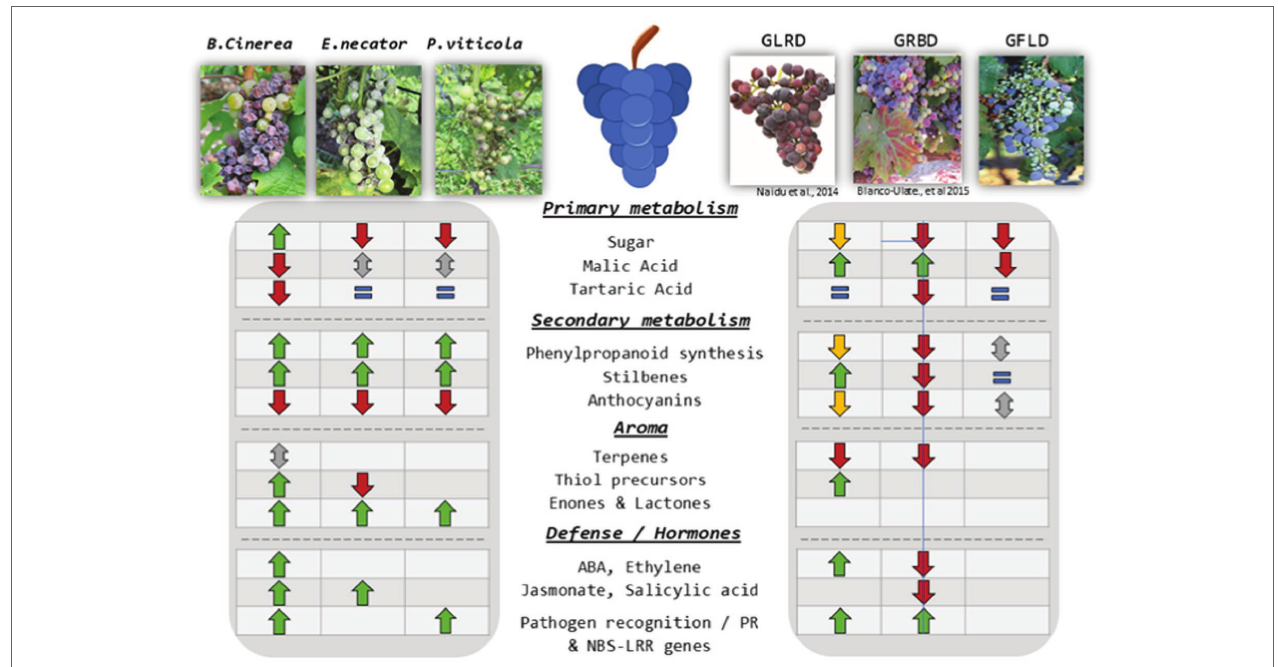
FIGURE 1 | General overview of most important metabolites and mechanisms modulated by the reviewed pathogens: ↓ : decrease; ↑ : increase; ↕ : opposed results reported; ↓ : decrease only in some studies likely due to sampling strategy, thus decrease putatively observed due to a delay in phenology; =: no